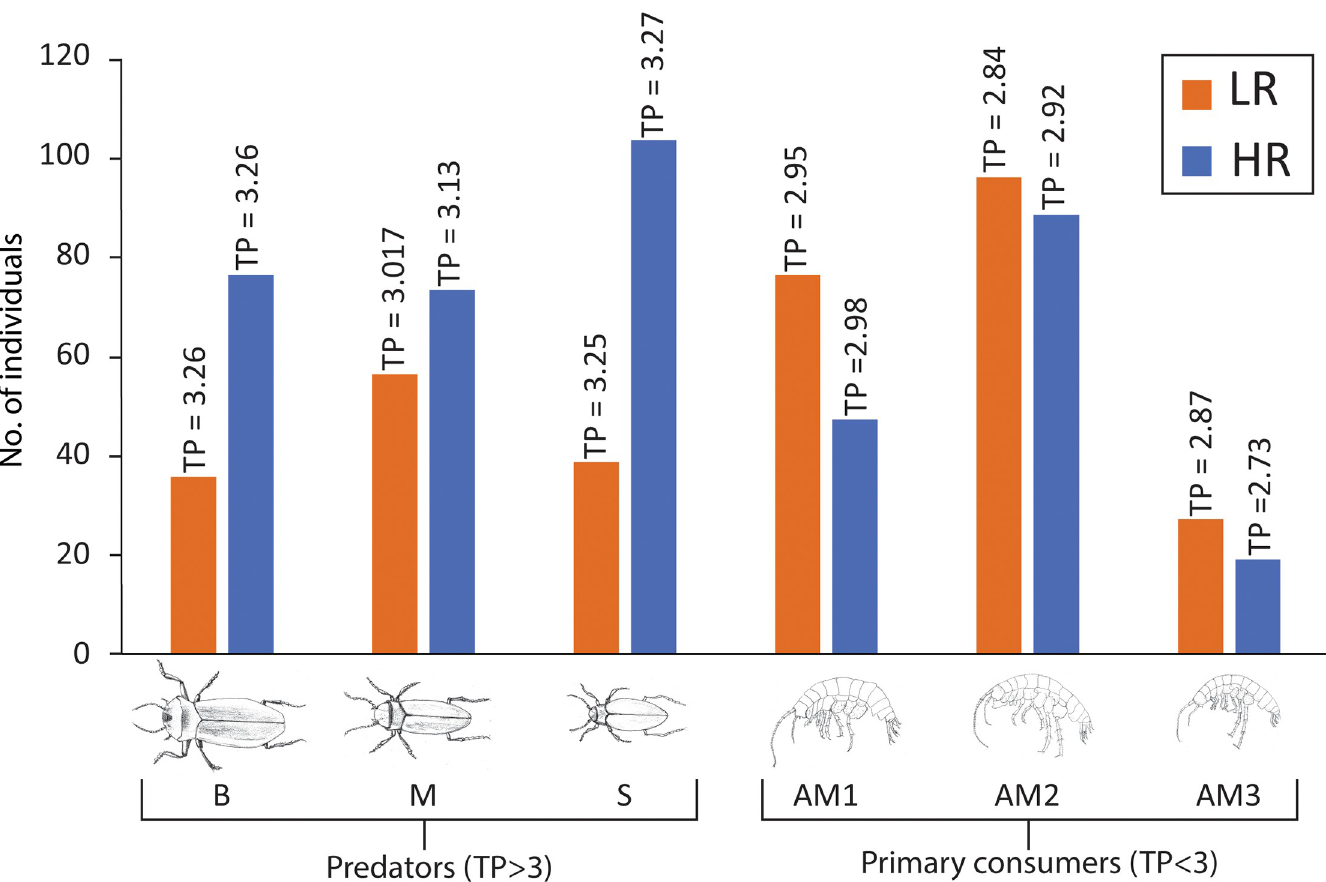
Fig 10. Bar chart graphs comparing dry season abundances (as the average value of LR1 and LR2) with HR conditions for top predators (beetles B, M and S) and key prey items (amphipods primary consumers AM1, AM2 and AM3). See S1 Table for detailed abundance data. None of the abundances of these taxa changed significantly between LR and HR. See Sacc ò et al. [38] for detailed statistical analyses across LR1, LR2 and HR.